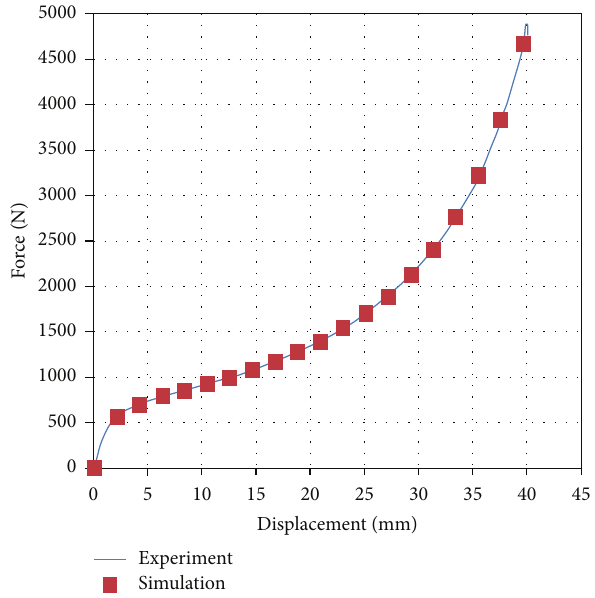
Figure 7: Comparison between the experimental and simulation results of the static compression test at 500